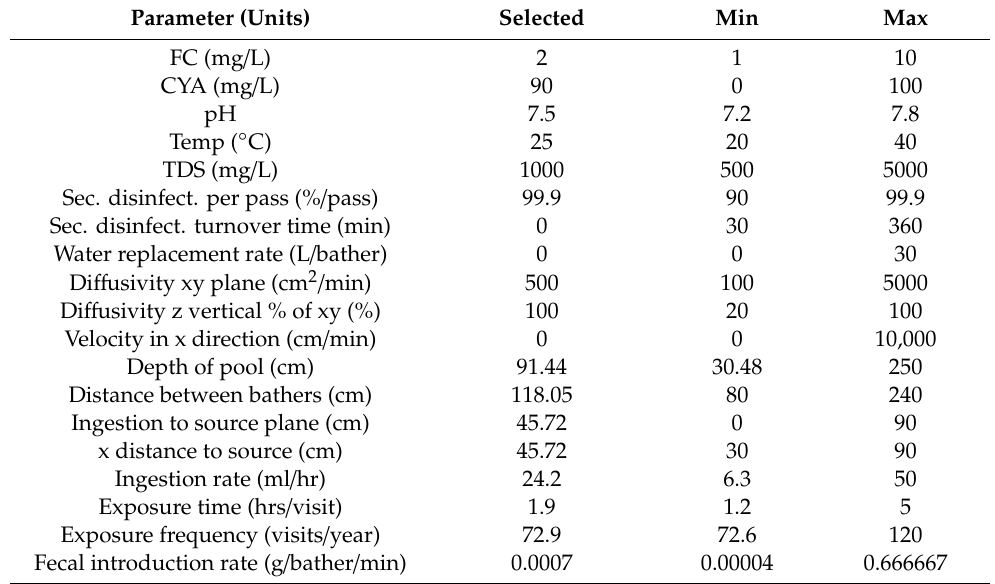
Table4. Selected, minimum, andmaximumvaluesusedinthesensitivityanalysisforallthreepathogens.